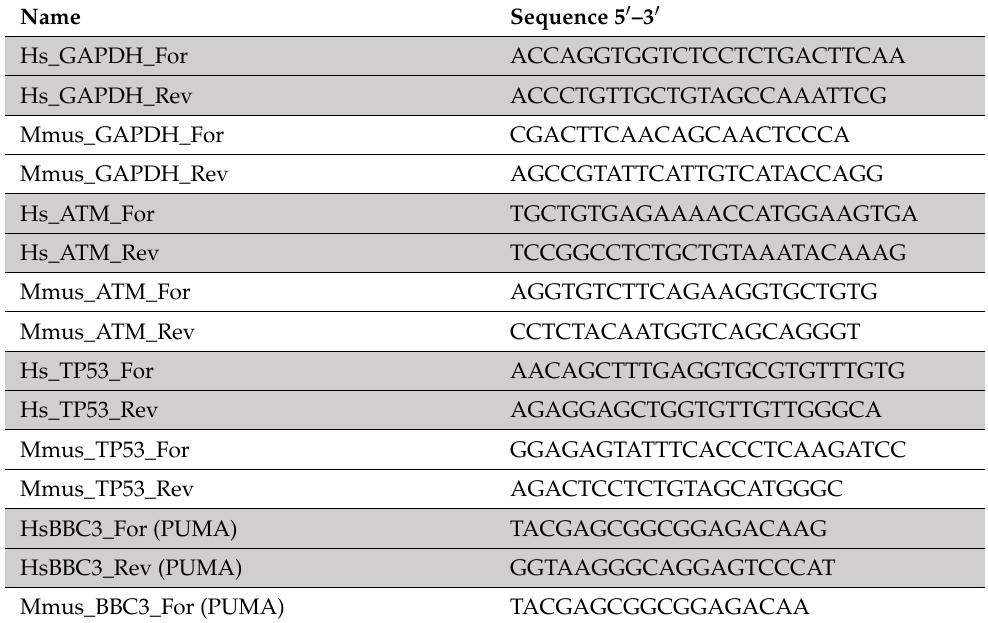
Table 1. Primers used in RT-qPCR reactions. For all studied genes two sets of primers pairs were used: For the mouse and human genes. The human genes primers are colored in